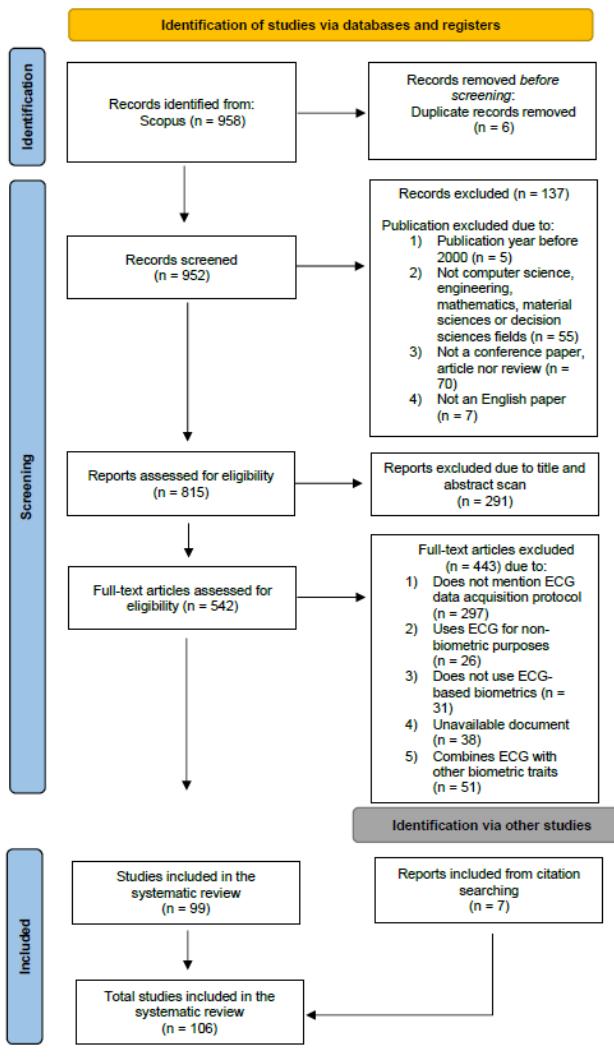
Figure 2. Flow diagram of the literature research process (adapted from Prisma Guidelines